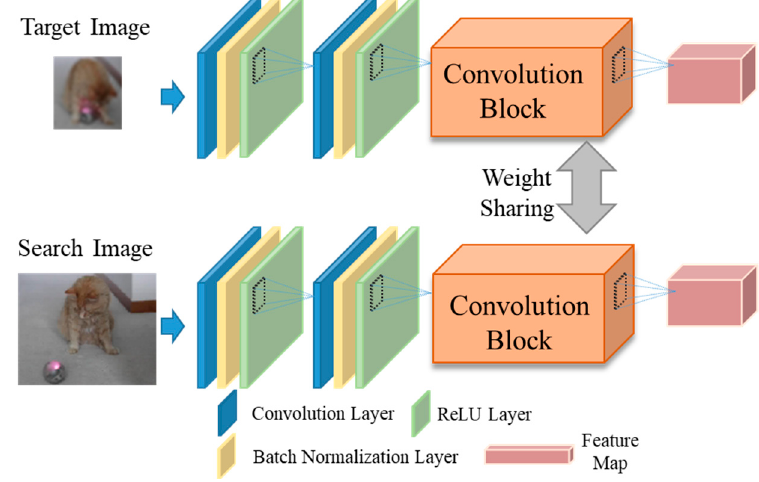
Figure 5. Proposed Siamese Network Architecture.